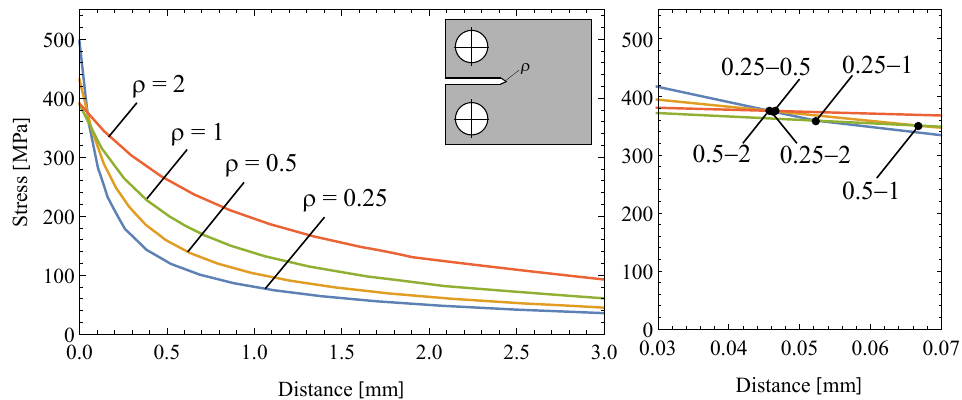
Figure 11. Stress-distance curves of the path obtained from numerical simulations for different notch radii conditions ( left ) and multiple intersections among these curves close to the notch root radius ( right